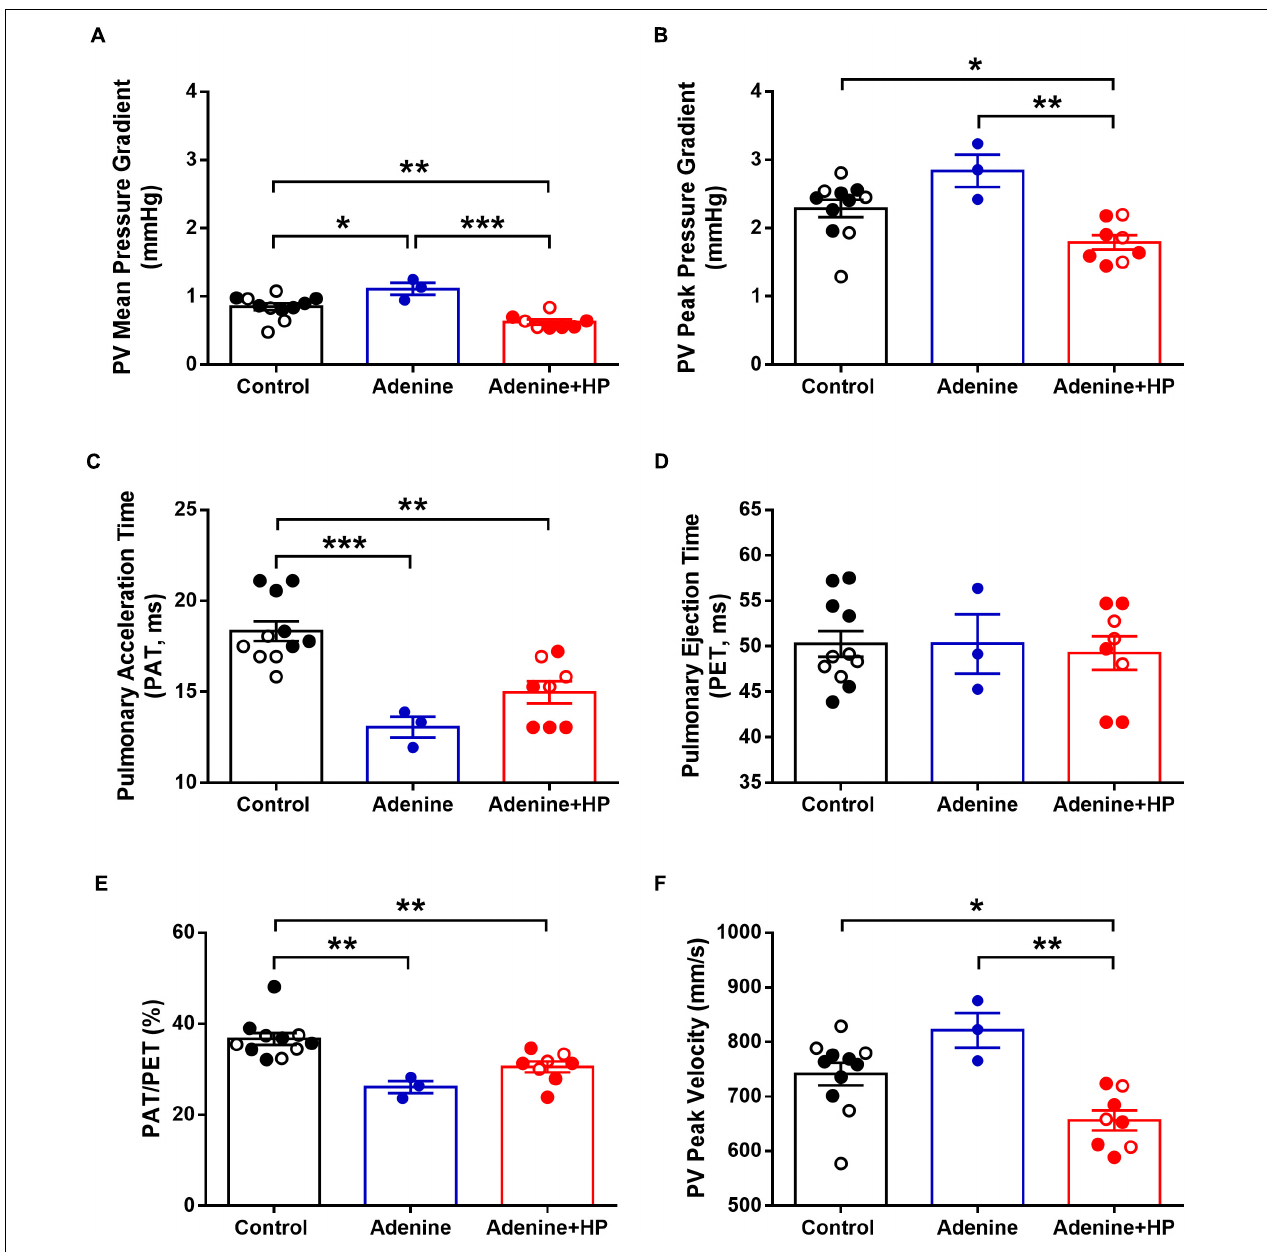
FIGURE 9 | Echocardiographic measures of pulmonary valve function. Pulmonary valve (PV) function assessed by echocardiography. PV (A) mean pressure gradient, (B) peak pressure gradient, (C) pulmonary acceleration time, (D) pulmonary ejection time, (E) ratio of acceleration to ejection time, and (F) PV peak velocity in the Control, Adenine, and Adenine + HP mice. One-way ANOVA with Tukey’s multiple comparisons test: * P < 0.05, ** P < 0.01, *** P < 0.001. Male mice (